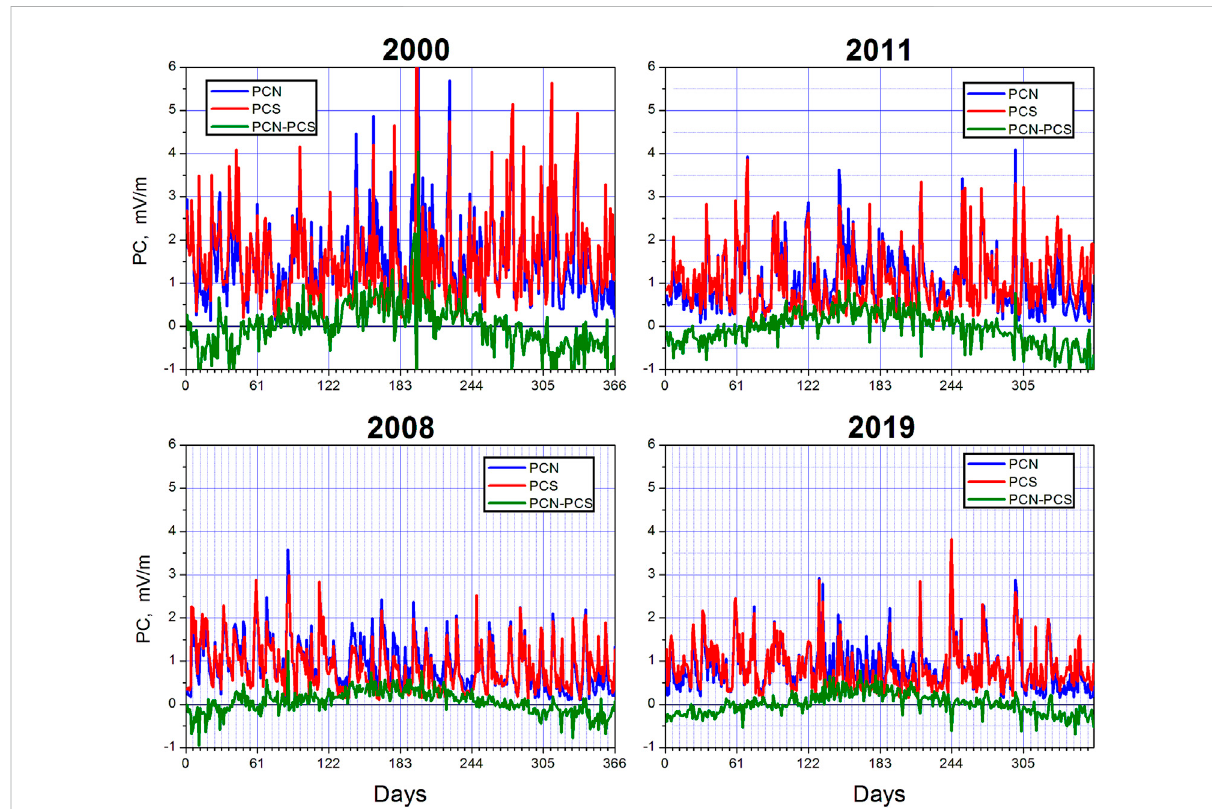
FIGURE 14 Courses of daily values of the PCN (blue) and PCS (red) indices and difference ( PCN-PCS ) (olive) in years of increased solar activity (2000, 2011) and in years of solar minimum (2008,